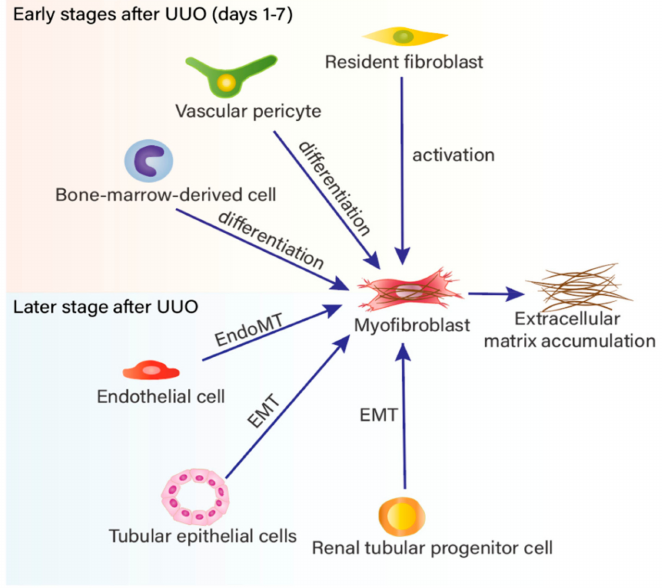
Figure 1. The cellular origins of myofibroblasts in renal fibrosis. The process of renal fibrosis is mainly regulated at the level of gene transcription in response to multiple extracellular fibrotic signals. Vital growth factors include transforming growth factor β (TGF- β ), platelet-derived growth factor (PDGF), basic fibroblast growth factor (FGF2), connective tissue growth factor (CTGF), epidermal growth factor